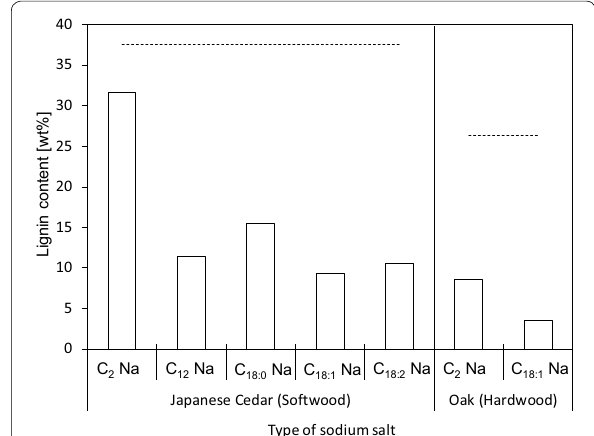
Fig. 2 Lignin content of Japanese cedar and oak after treatment with 20% sodium soaps dissolved in glycerol at 250 °C for 1 h. Dashed lines show lignin content of untreated samples